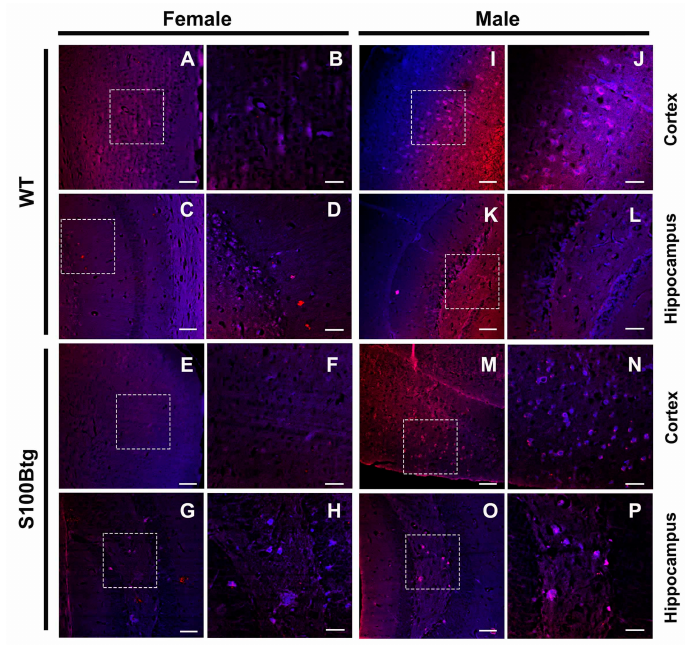
Figure 4. Brain amyloid- β deposition in one-year-old S100Btg and wt mice. In ( A – H ), A β 42 im- munofluorescent images of female wt and S100Btg mice, magnified by 10 × and 40 × , respectively. ( B , D , F , H ) are higher magnifications corresponding to the squares in ( A , C , E , G ), respectively. In ( I – P ), fluorescent images of male wt and S100Btg mice, magnified by 10 × and 40 × , respectively. ( J , L , N , P ) are higher magnifications corresponding to the squares in ( I , K , M , O ), respectively. Scale bars = 150 µ m (left panels) and 50 µ m (right